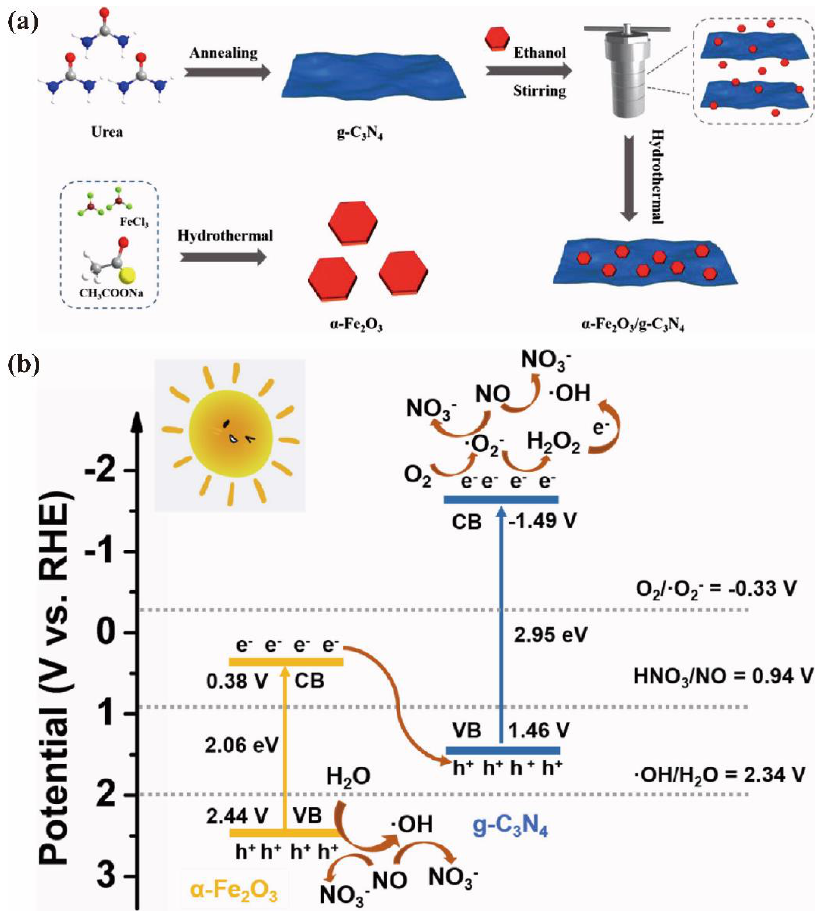
Figure 14. ( a ) Schematic illustration for the preparation of α− Fe 2 O 3 /g − C 3 N 4 direct Z − scheme heterojunc-